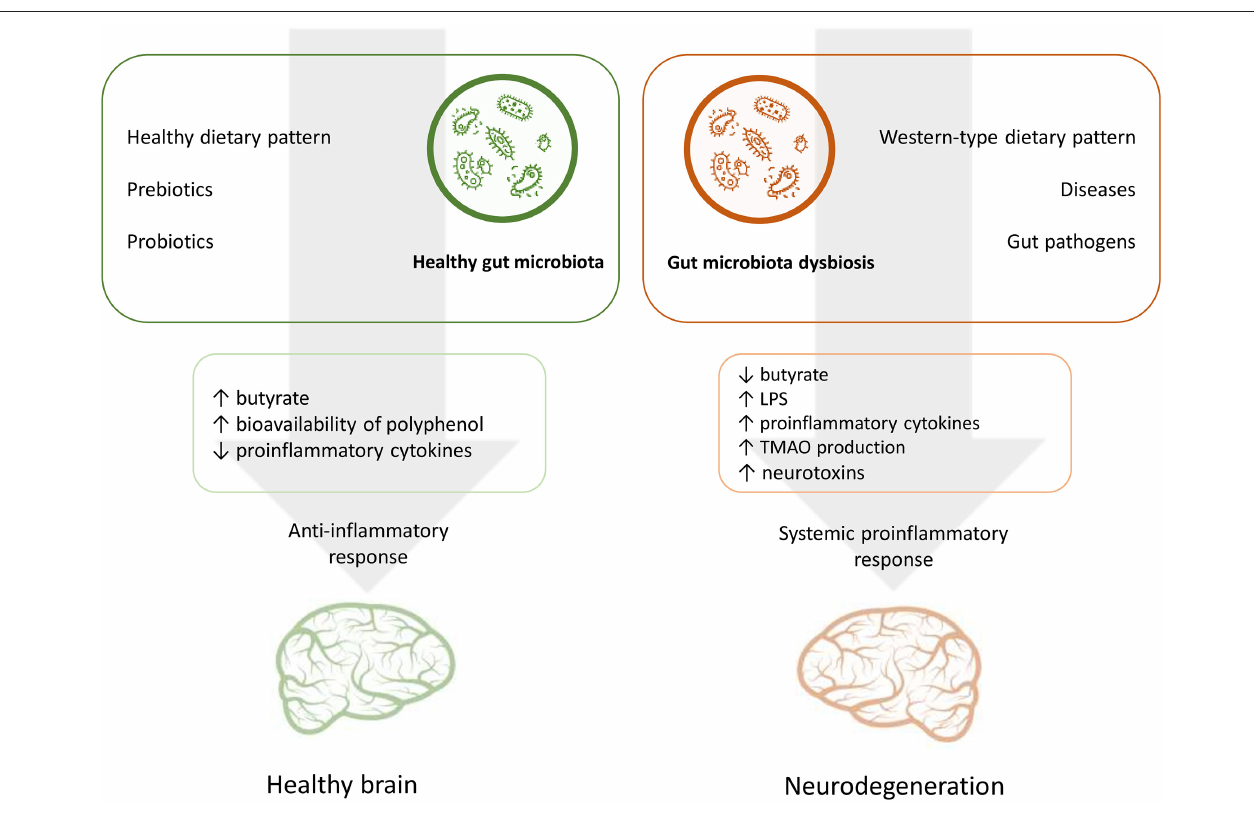
FIGURE 1 | The role of nutrition and gut microbiota in the pathogenesis of Alzheimer’s